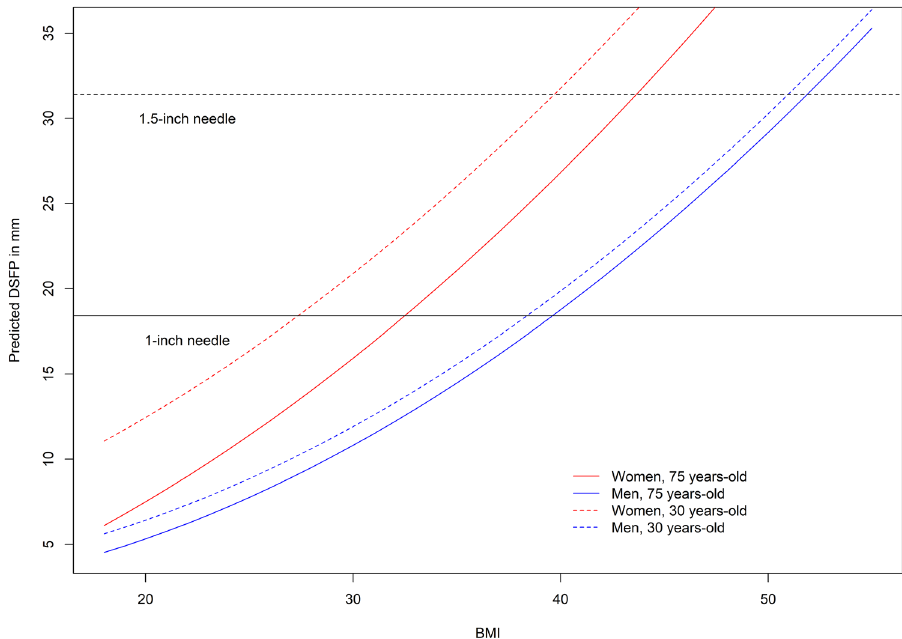
Figure 4. Predictive modeling of DSFP thickness in mm by BMI for individuals from Eq. 1. Red solid line represents the predicted DSFP for women aged 75 years. Red broken line represents the predicted DSFP for women aged 30 years. Blue solid line represents the predicted DSFP for men aged 75 years. Blue broken line represents the predicted DSFP for men aged 30